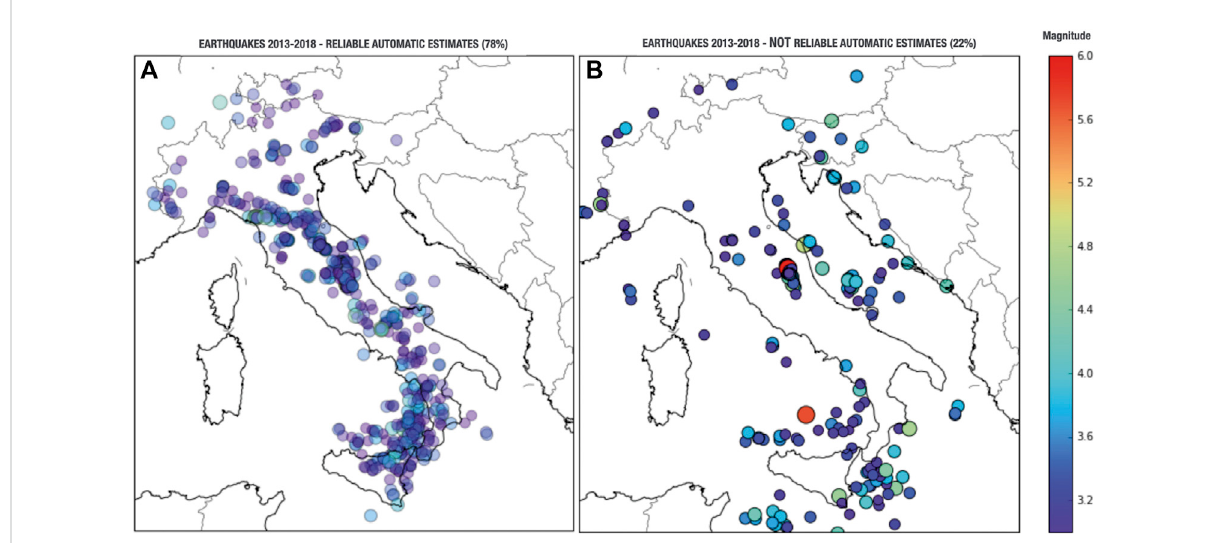
Earthquakes with M ≥ 3 recorded from 1 January 2013 to 1 September 2018 in Italy and surrounding regions (A) reliable automatic estimates (78%ofalltheeventswithM ≥ 3)thatsatisfyallthefollowingconditions:a)magnitudeM ≥ 3calculatedonanumberofchannelsgreaterthan10 · M;b) morethansixobservations;c)rootmeansquare < 1.5anderrorindepth < 10.0km;d)azimuthalgapbetweenseismicstations < 180 ° ,distancefrom fi rst station < 100.0 km (B) automatic estimates that don ’ t satisfy the conditions of reliability The unreliability of the automatic solutions